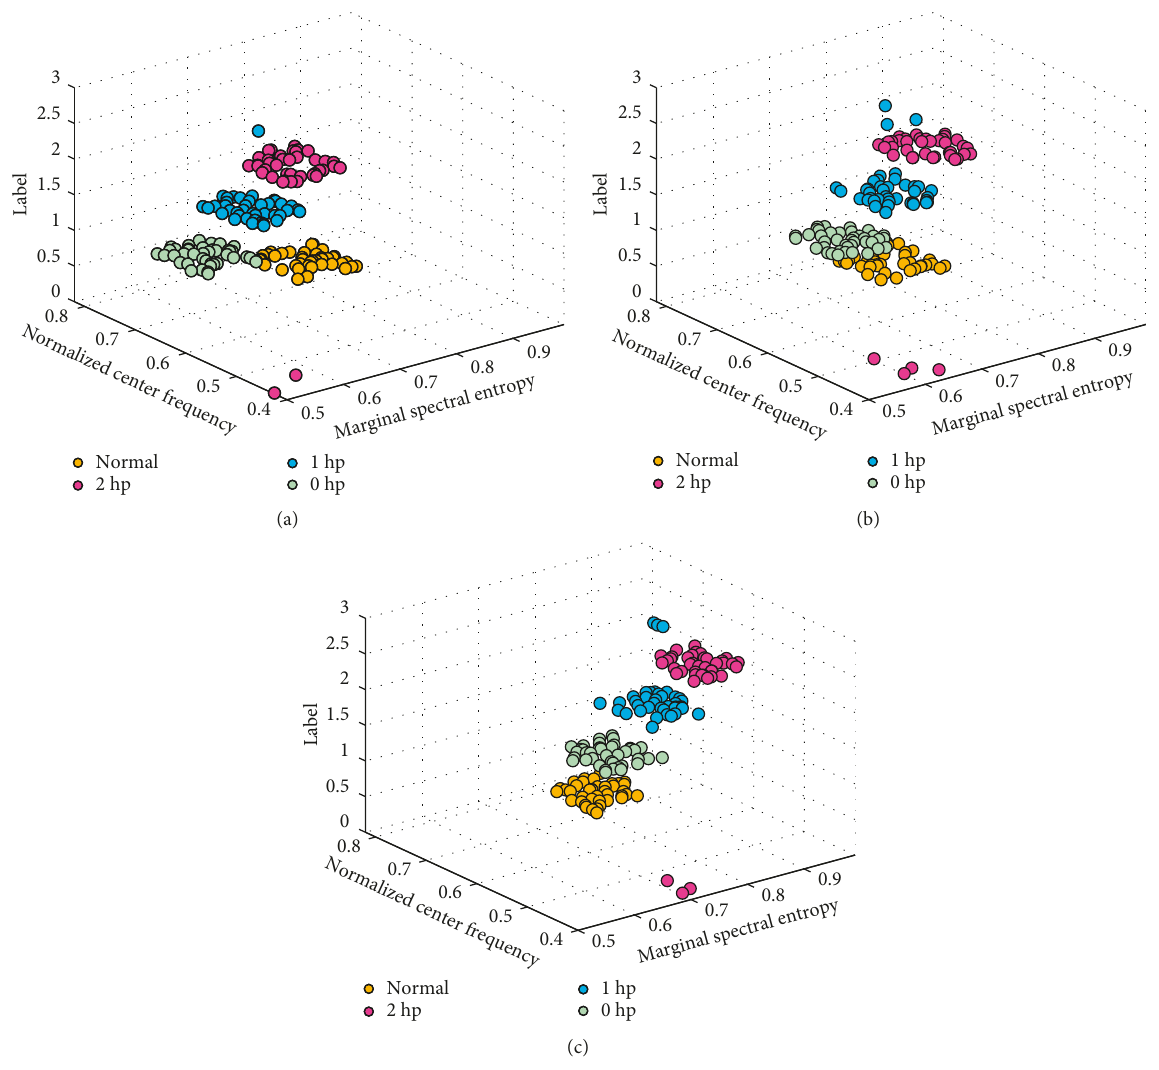
Figure 14: Intelligent diagnosis of bearing faults with minor damage under three different load conditions. (a) Bearing outer race fault. (b) Bearing rolling ball fault. (c) Bearing inner race fault. Table 5: Performance comparison of different classification